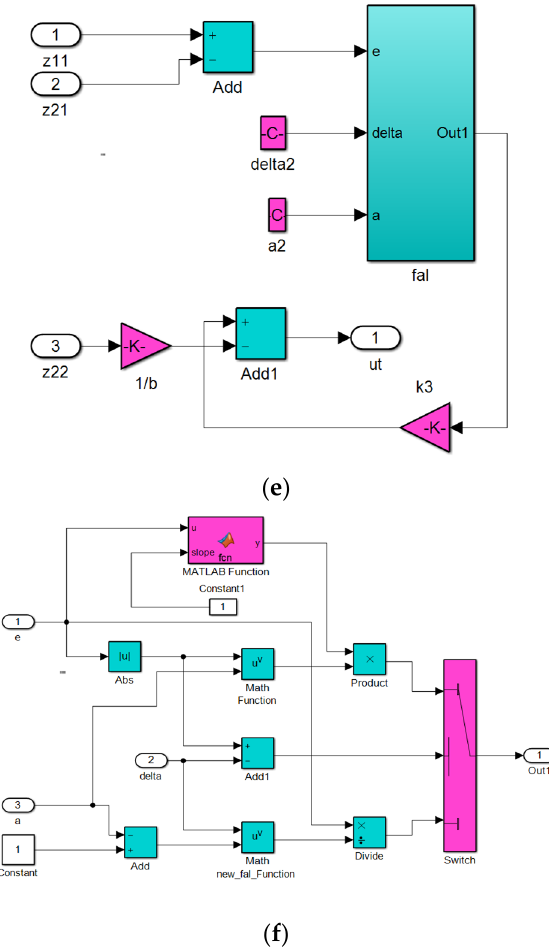
Figure 4. I ‐ ADRC simulation structure diagram: ( a ) overall simulation diagram, ( b ) I ‐ ADRC mod ‐ ule, ( c ) TD module, ( d ) ESO module, ( e ) NLSEF module, and ( f ) ESO module.